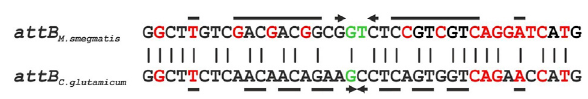
FIGURE 2 | Alignment of the minimal required bacterial attachment site sequences of the phage Bxb1 in its natural host M. smegmatis and the observed attachment site in C. glutamicum . Base pairs coloured in red are speci fi c for attB identity in M.smegmatis . The green central GT is the essential dinucleotide for recombination and the dashed arrows indicate palindromic base